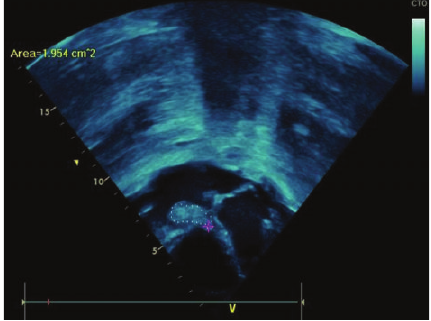
Figure 2: Tricuspid septal leaflet vegetation.